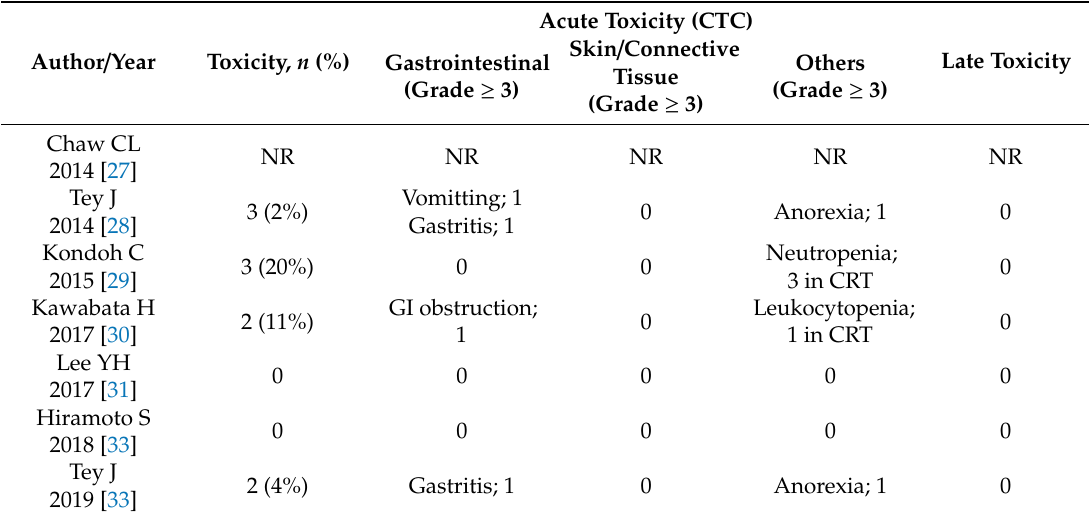
Table 4. Toxicity of palliative RT for bleeding from gastric